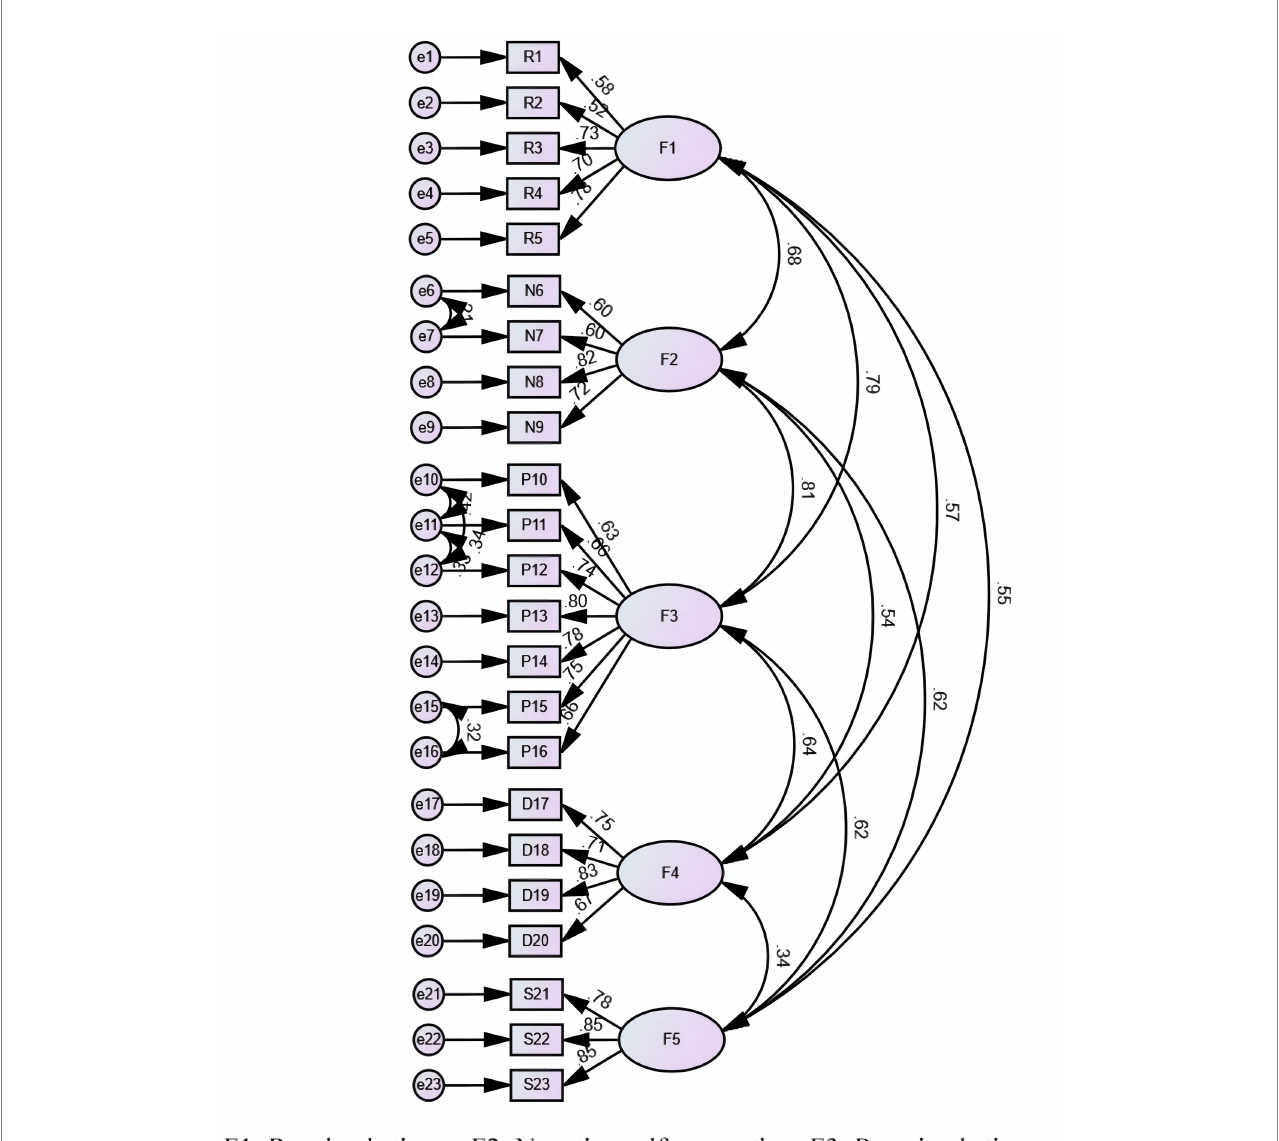
FIGURE 1 Standardized path diagram of confirmatory factor